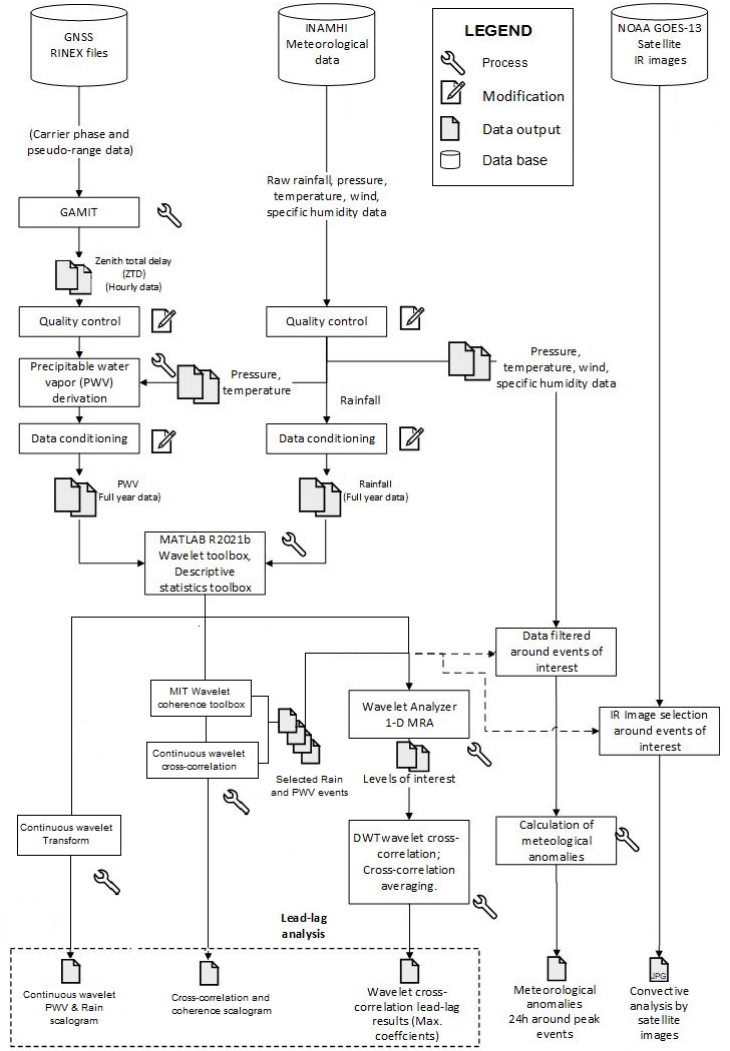
Figure 3. Data processing framework was applied to each of the five studied locations.